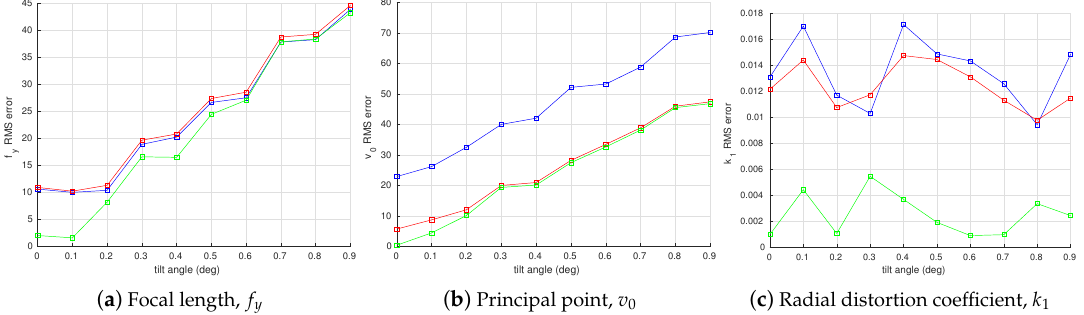
Figure 11. Root-mean-square error (RMSE) in camera intrinsic parameters w.r.t. error in the angle between two planes of the calibration target. The blue, red, and green plots represent RMSE of the conventional method [19], the proposed method without joint optimization, and the proposed method with joint optimization, respectively.